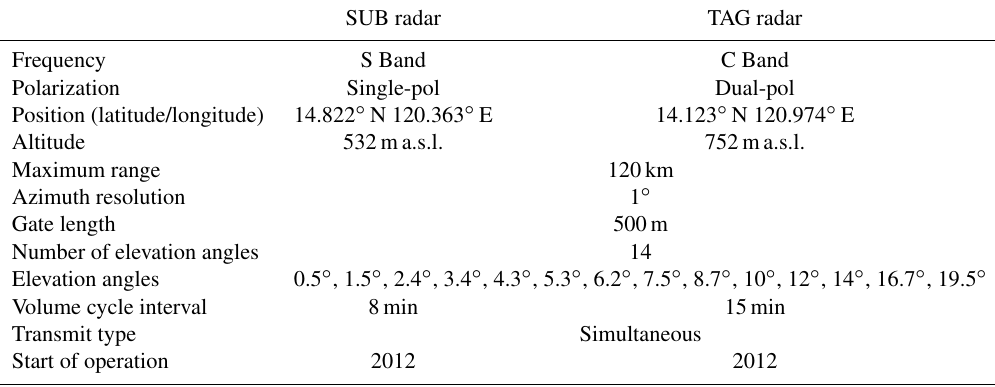
Table 1. Technical specifications of the SUB and TAG radars.